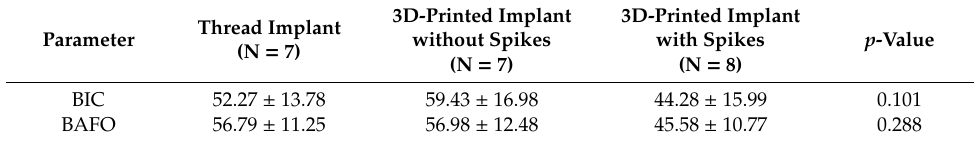
Table 3. Bone-to-implant contact and bone area fraction occupied in the three implant